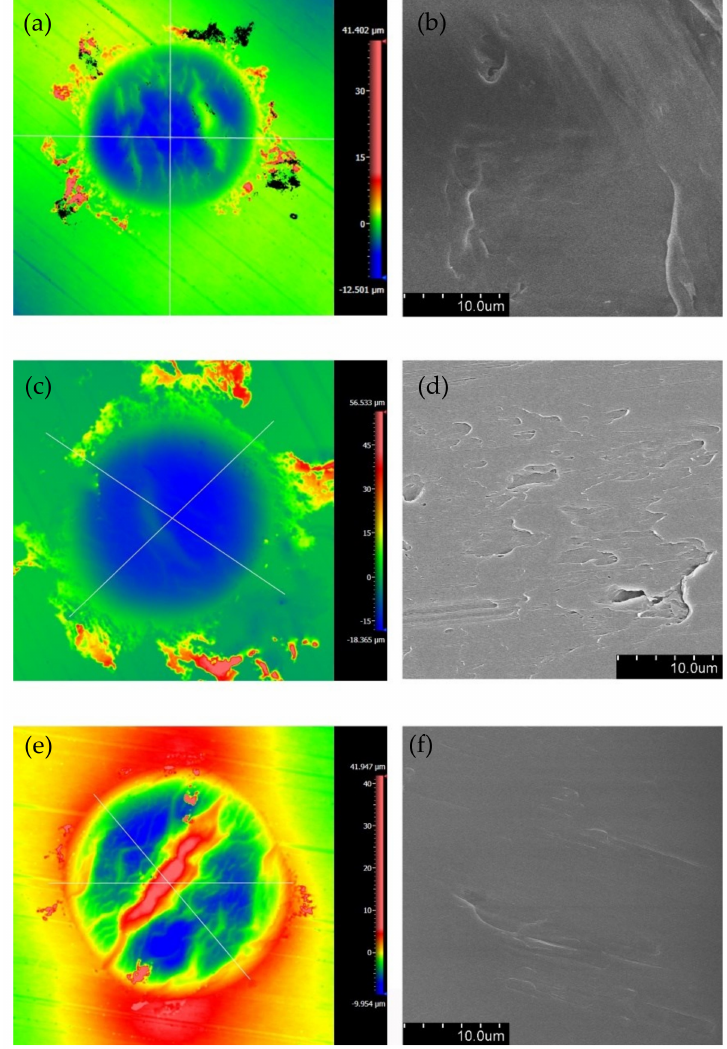
Figure 16. The 2D surface topographies and SEM topographies of PVDF thin films with ƒ = 30 Hz and V c = 0 V: ( a , b ) topographies with F n = 15 N and D = ± 20 µ m, ( c , d ) topographies with F n = 15 N and D = ± 40 µ m, ( e , f ) topographies with F n = 50 N and D = ± 20 µ